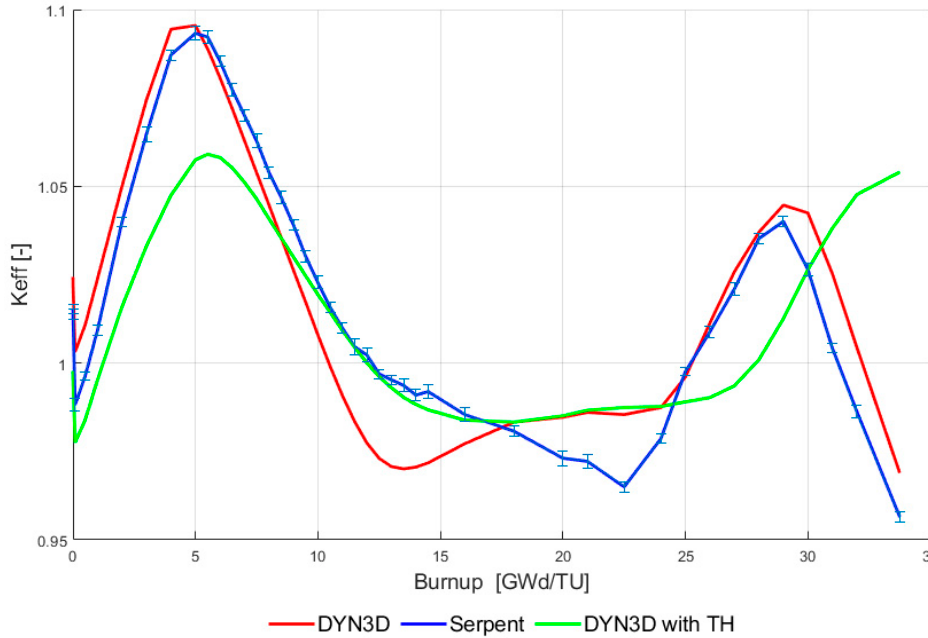
Figure 22. Fuel assembly two fuel burnup comparison between DYN3D and Serpent.